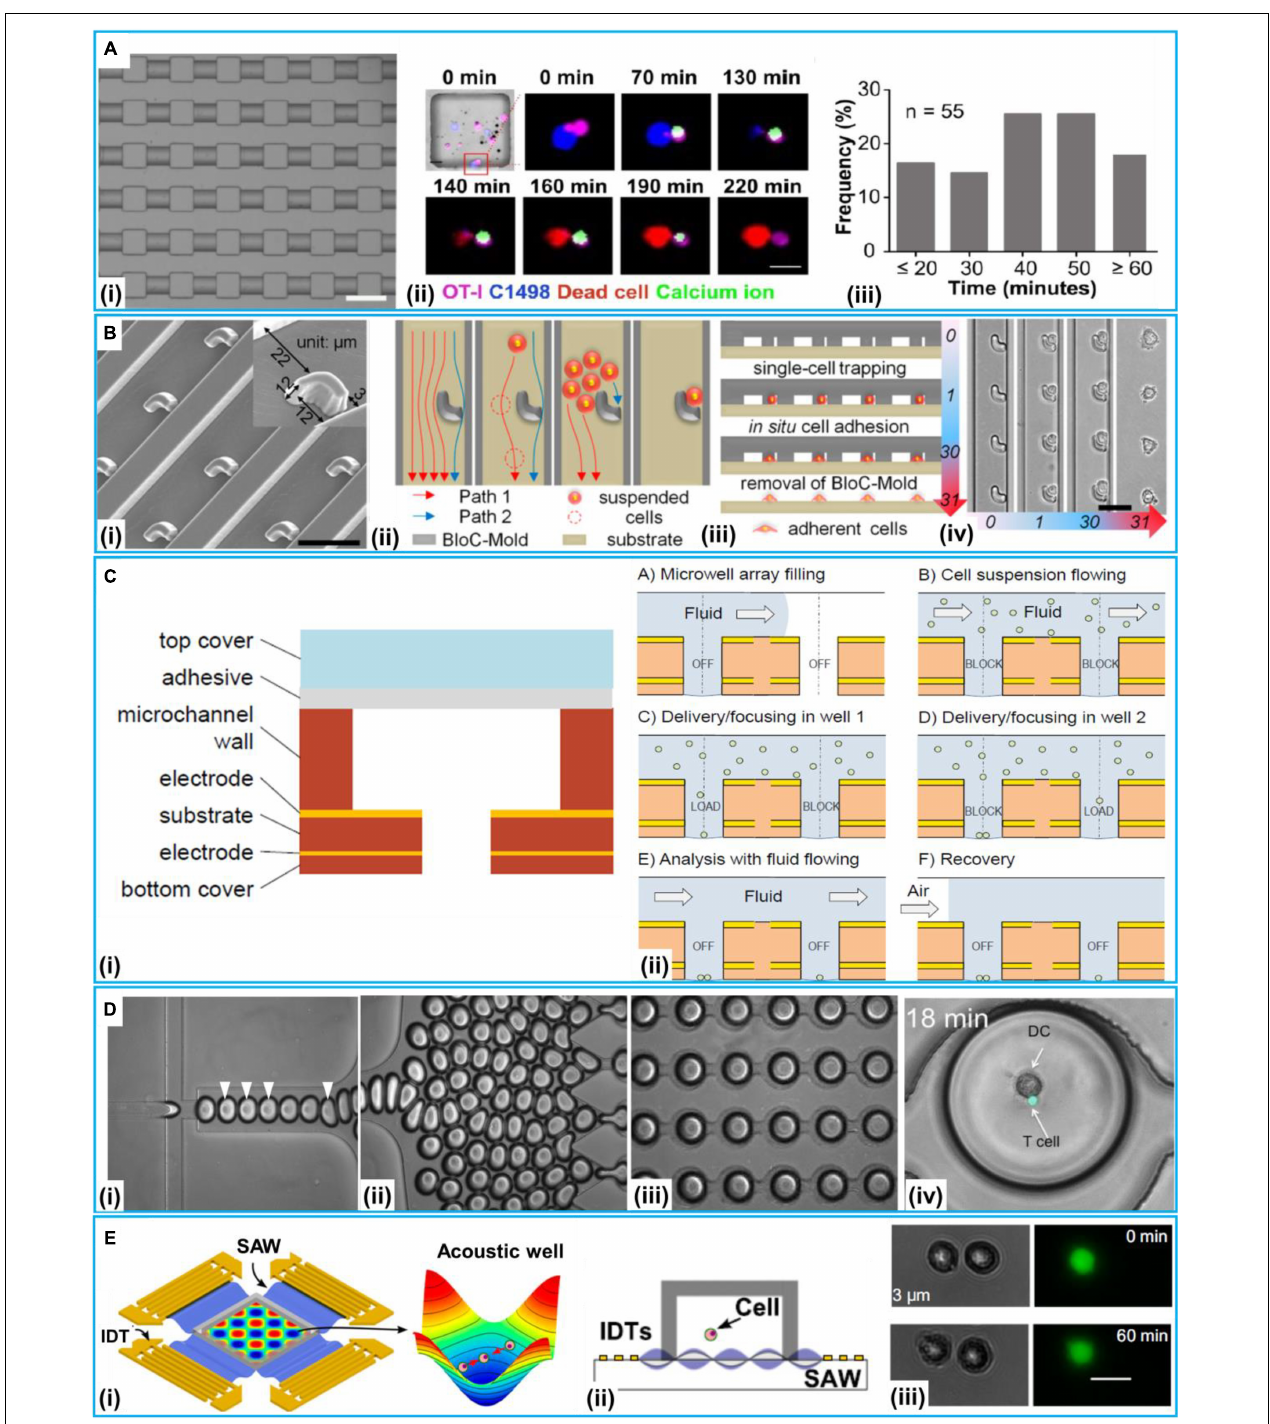
FIGURE 3 | 2D microfluidic systems at a single-cell level. (A) Microwell method. (i) Microscopic image. (ii) The real-time imaging of immunological synapse formation between T cells (OT-I) and leukemia cells (C1498) via calcium imaging. (iii) The frequency distribution of the time duration from Ca 2 + entered into OT-I cells to leukemia cells death. Reproduced with permission from Tu et al. (2020), copyright 2020 The Royal Society of Chemistry. (B) The procedure of hook-shaped traps for cell pairing. (i) Scanning electron micrograph of the trap microarray. (ii) Schematic diagram of cell flow paths. Cross-sectional schematics (iii) and corresponding bright-field micrographs (iv) showing the entire BloC-Printing process. Reproduced with permission from Zhang et al. (2014), copyright 2014 The National Academy of Sciences of the United States. (C) The Electric-field-based open microwell system for cell pairing. (i) The build-up of the open microwell array. (ii) The procedure